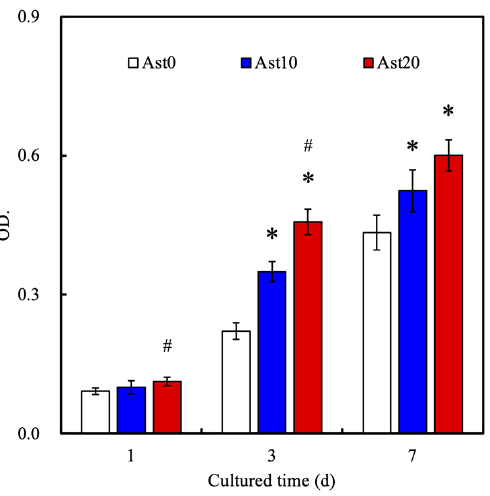
Figure 5. Proliferation of rat Schwann cells (RSCs) on 3D-printed Ast-containing conduits for 1, 3, and 7 days. * Significant difference ( p < 0.05) from the Ast0 group. # Significant difference ( p < 0.05) from the Ast10 group.